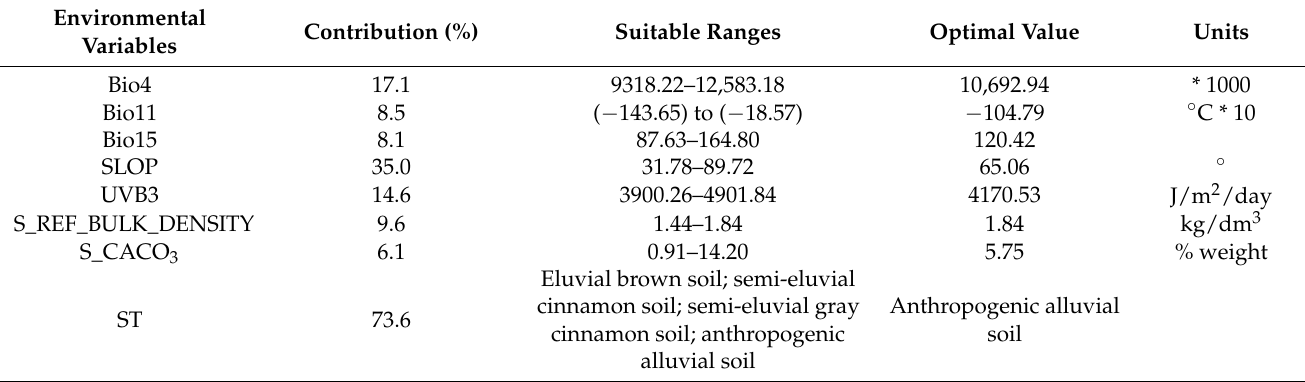
Table 1. Contribution value, optimal and threshold values for each key environmental variable under current scenario.